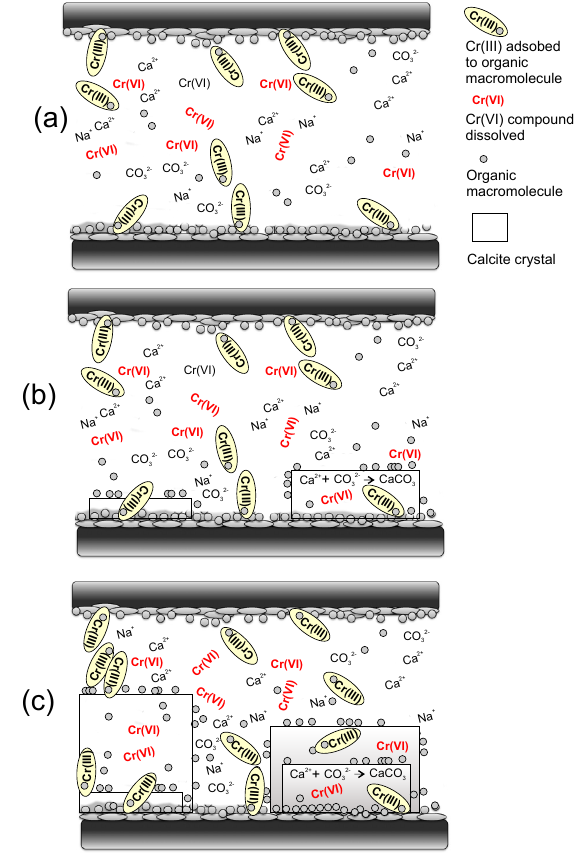
Figure 8. Schematic representation of a simplified model for the transfer of chromium from an extrapallial fluid within an interlamel- lar space into shell carbonate nuclides (modified from Suzuki and Nagasawa, 2013). The insoluble frameworks consist of chitin (black and long rectangles) that make a scaffold to supply the space for pre- cipitation of calcium carbonate crystals. (a) The interlamellar space is filled with a supersaturated extrapallial fluid with respect to CO 2 − 3 and Ca 2 + . Cr(VI) likely occurs as dissolved compounds in the fluid and is eventually reduced to isotopically lighter Cr(III) by dissolved organic macromolecules (gray circles) onto which it is efficiently adsorbed. Insoluble matrix proteins (gray discs) have the hydropho- bic region for organic macromolecules (protein) – chitin interaction and the hydrophilic – acidic region for the calcium carbonate bind- ing ability to mediate the connection between the organic scaffolds. (b) The soluble matrix proteins that have a hydrophyllic region for calcium carbonate binding adhere to the chitinous layers and prob- ably regulate nucleation, crystal polymorph and crystal orientation of inorganic calcium carbonate crystals (gray rectangles). (c) As the crystals grow, insoluble matrix proteins are used for organic frame- work formation as intercrystalline organic matrices and soluble ma- trix proteins, including adsorbed Cr(III), are eventually included in the calcium carbonate crystals as intracrystalline organic matrices. Cr(VI) potentially present as chromate (CrO 2 − ) ions likely also 4 substitute for carbonate (CO 2 − ) ions directly in the calcium car- 3 bonate lattice (Tang et al.,